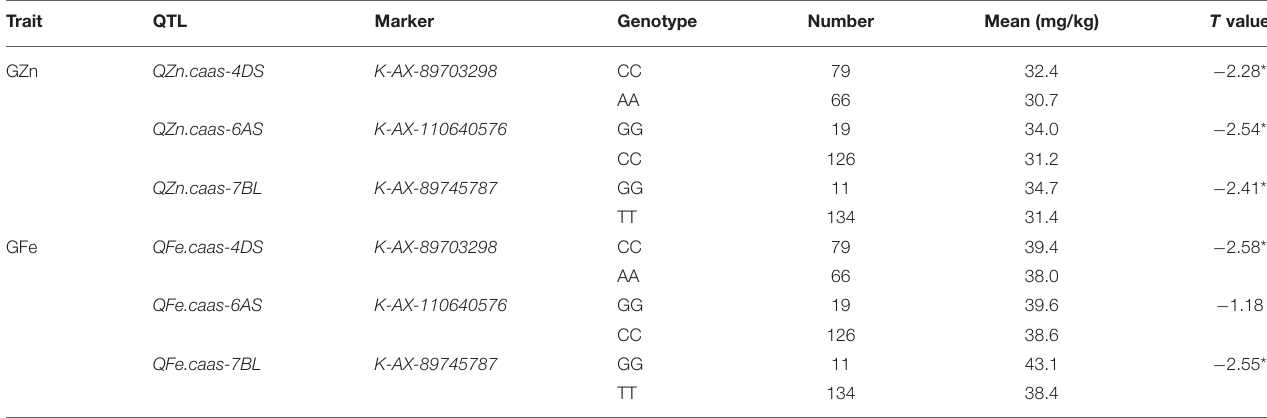
TABLE 7 | Mean values of GZn and GFe for genotype classes in the germplasm panel. Trait